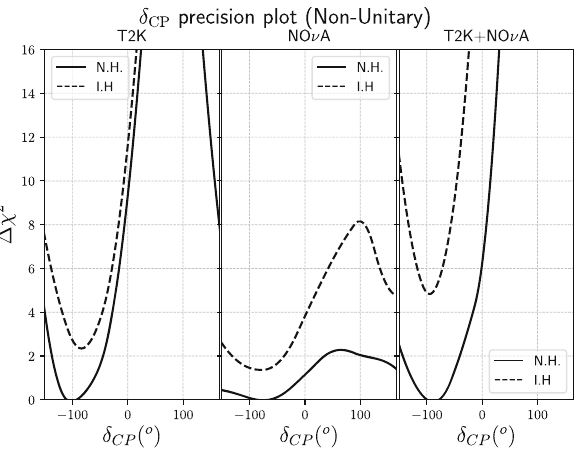
Fig. 15 (cid:6)χ 2 as a function of δ CP for the individual T2K and NO ν A, and the combined analysis. These results are for 2019 data. The limiting values of (cid:6)χ 2 for 1 σ and 2 σ CL are 1 and 4